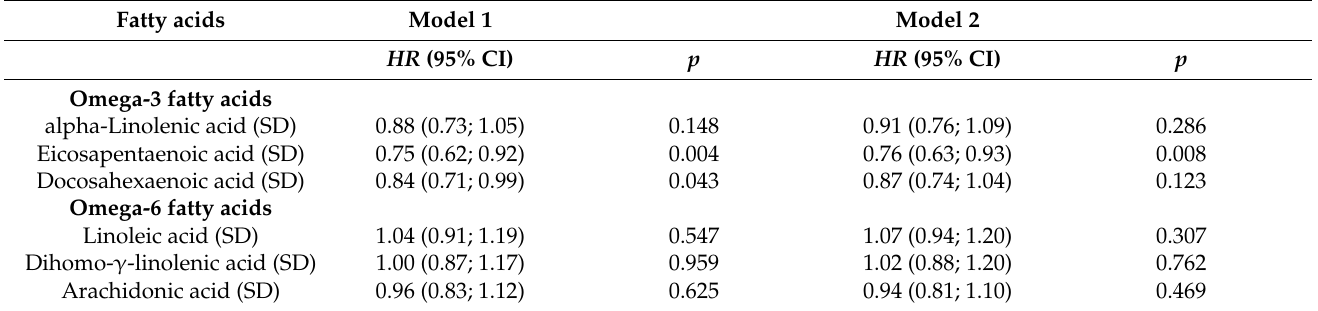
Table 4. Longitudinal associations between concentrations of n-3 and n-6 fatty acids in serum phospholipids and incident AD dementia over a 7-year follow-up period ( n = 1221).